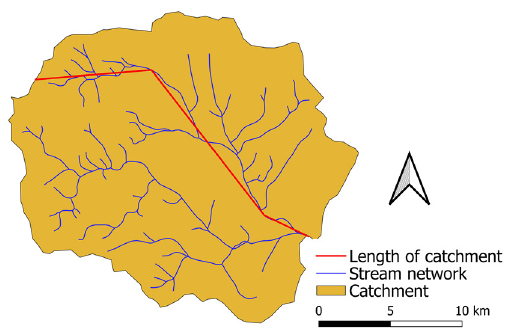
Figure A1. Illustration of catchment length determination.